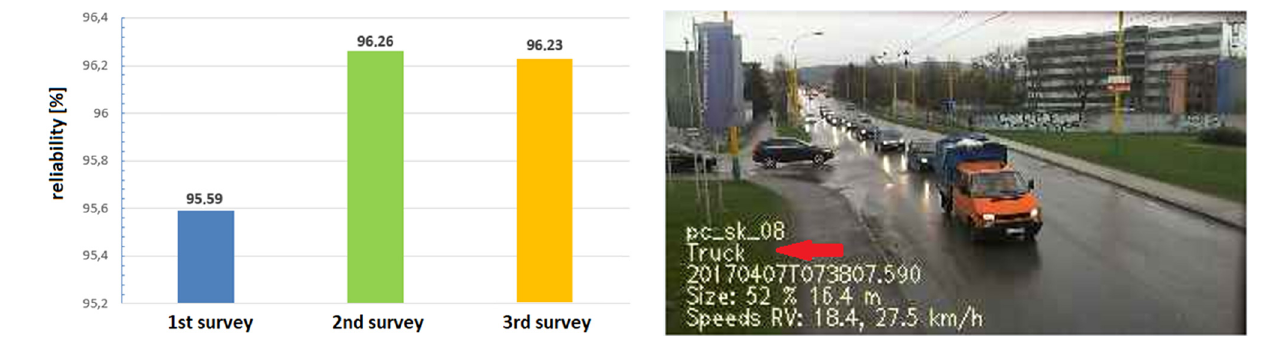
Figure 12: Incorrect passenger car classi fi cation [ 15 ]